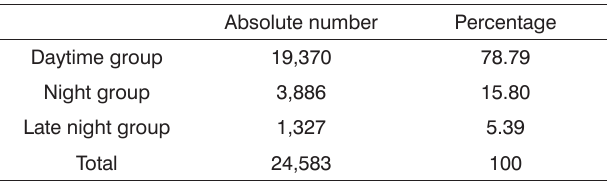
Table 3. Absolute number and percentage of visits to the otorhinolaryngology